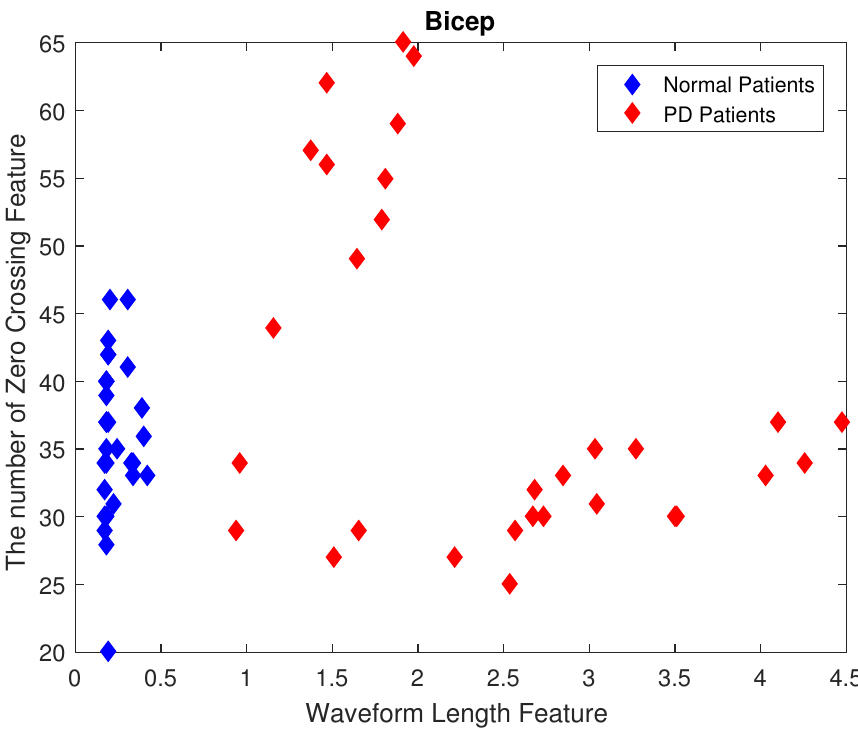
Figure 12. Two-dimensional scatter plot of zero crossing (ZC) feature vs. waveform length (WL) feature of biceps brachii sEMG sensor for normal and PD patients.